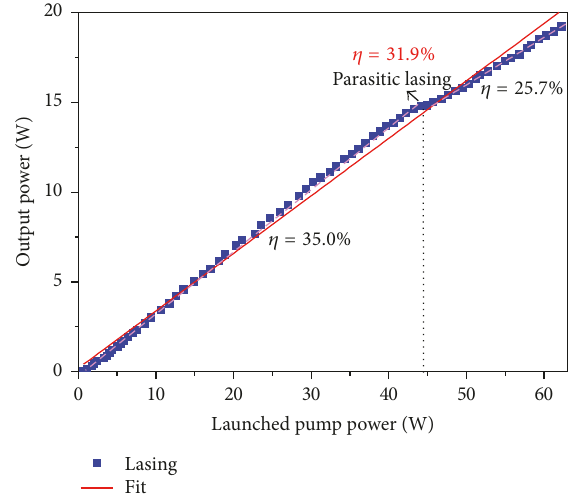
Figure 3: Laser output powers as a function of the launched pump power.